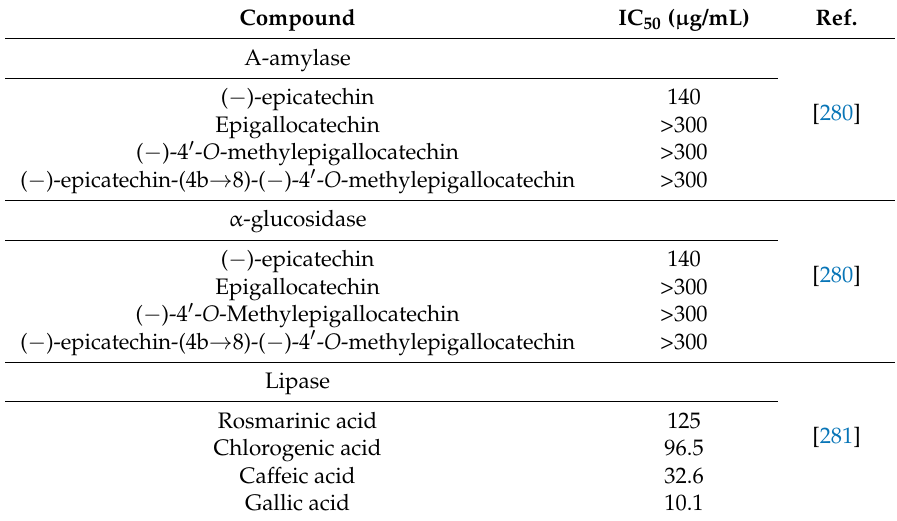
Table 4. Phenolics bearing digestive enzyme inhibitory